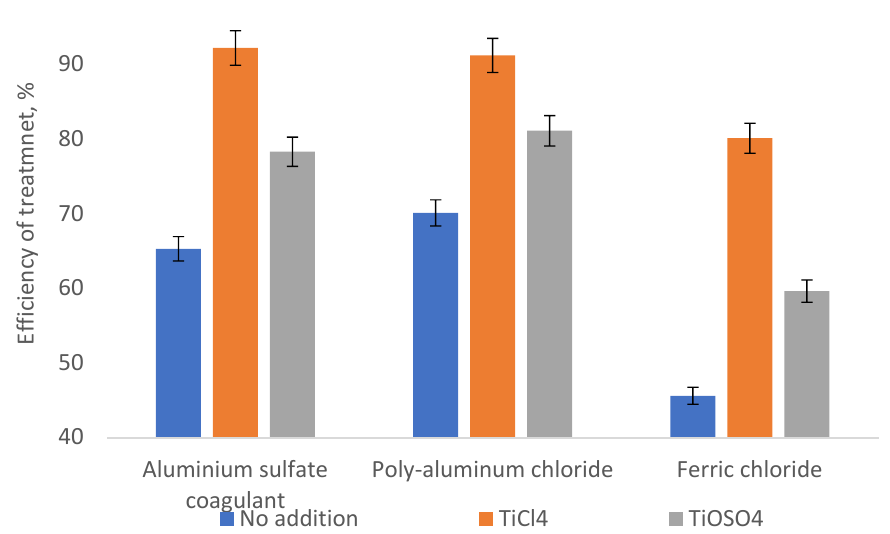
Figure 3. Efficiency of removing suspended solids from the alcohol industry wastewater by various coagulants.